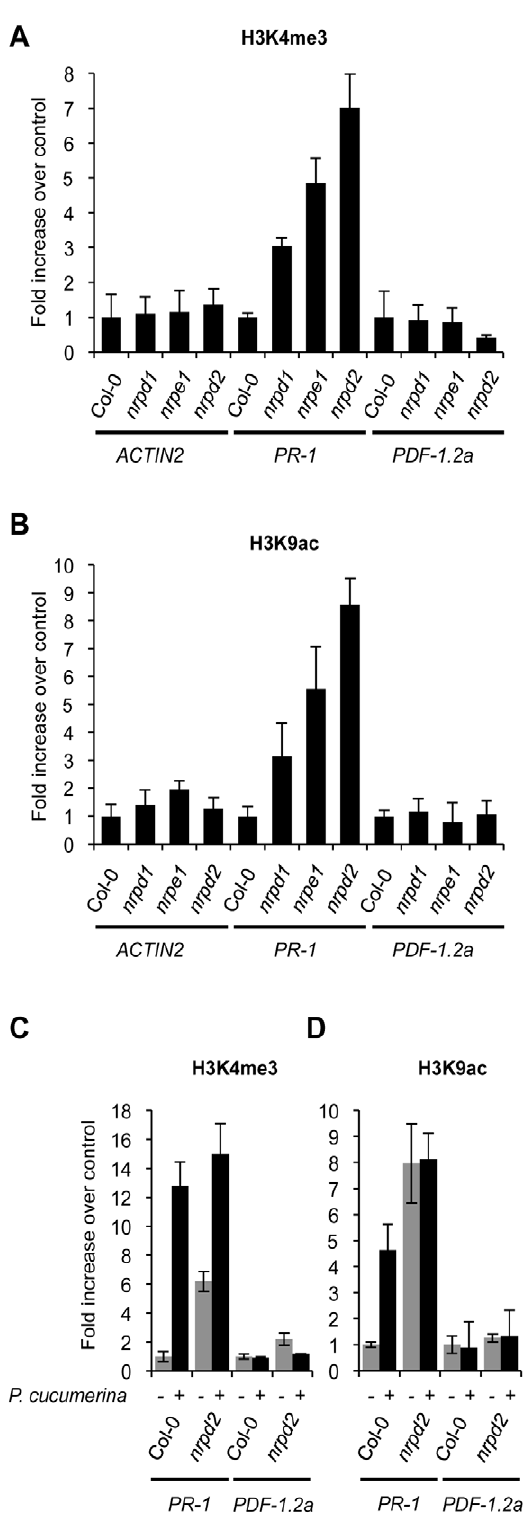
Figure 5. Histone H3 modifications. Comparative level of histone modifications of PR-1 , PDF1.2a and Actin2 gene promoters as present in leaf samples from Col-0, nrpd1 , nrpe1 and nrpd2 plants. (A) Histone H3 Lys4 trimethylation (H3K4me3) on the indicated gene promoters. (B) Histone H3 K9 acetylation (H3K9ac) on the indicated gene promoters. Data are standardized for Col-0 histone modification levels.